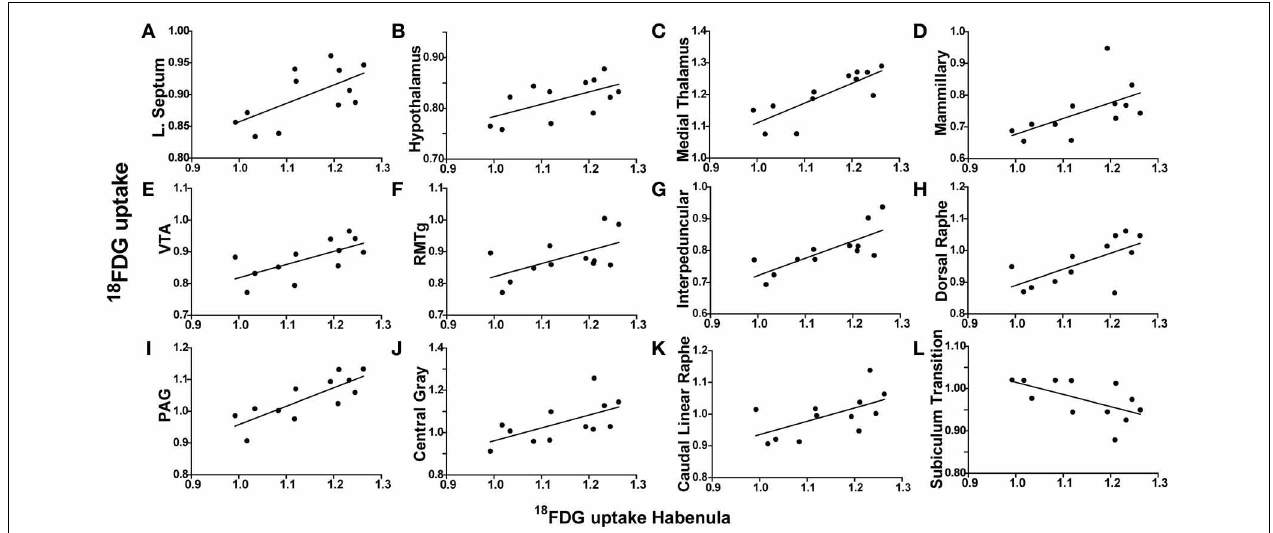
FIGURE 3 | Habenula metabolic activity regional correlates. (A–L) 18 FDG uptake in the habenula (x-axes) correlates with 18 FDG uptake in several brain regions (y-axes) including the lateral septum (A) , hypothalamus (B) , medial thalamus (C) , mammillary nuclei (D) , ventral